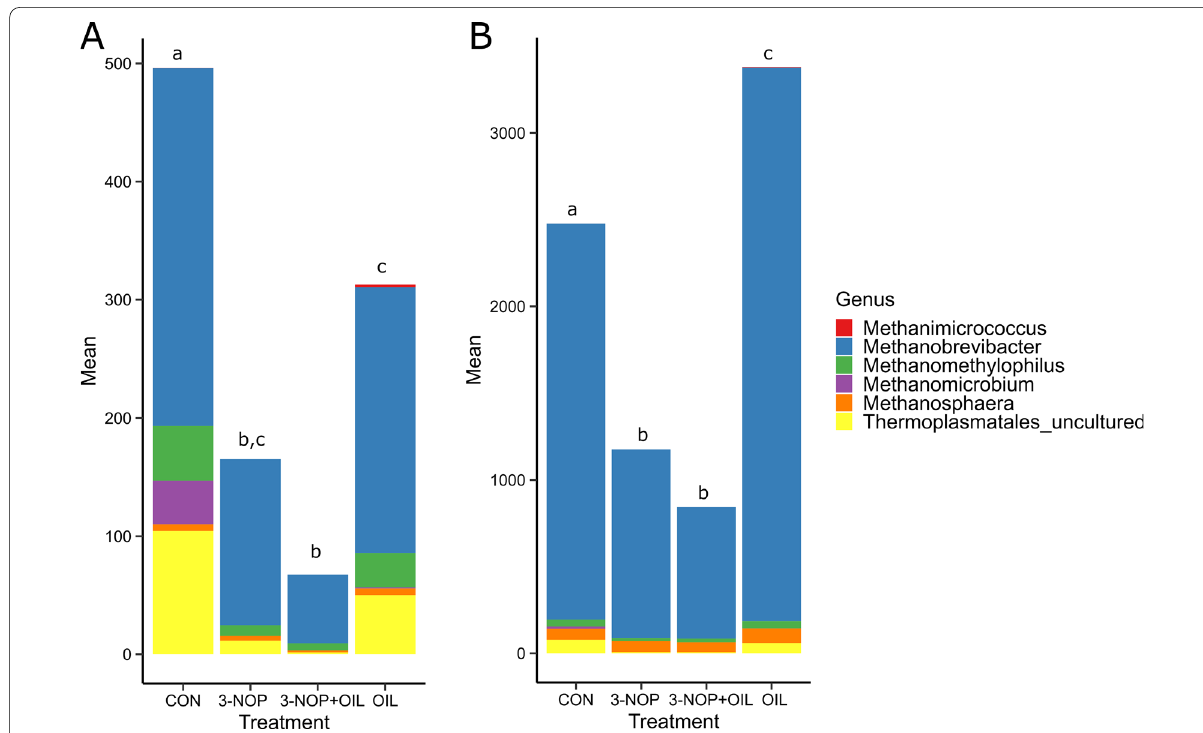
Fig. 2 Impact of CH 4 inhibitors on the abundance of rumen methanogens in A Rumen fluid and B Rumen digesta. The mean count of ASVs assigned to genera in the phylum Euryarchaeota is shown. Treatments resulting in statistically significant differences in the total count of ASVs classified within the phylum Euryarchaeota are indicted by a unique letter in each